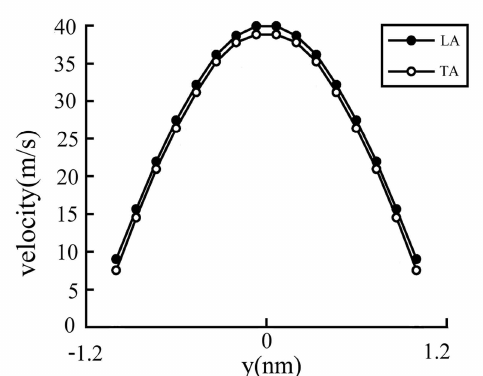
Figure 2 . Poiseuille flow simulations of case 1 (high flow velocity simulations). The vertical coordinate is the flow velocity and the horizontal coordinate is the height of the channel. is the result of this paper (LA ). is the result of the traditional (TA) method.